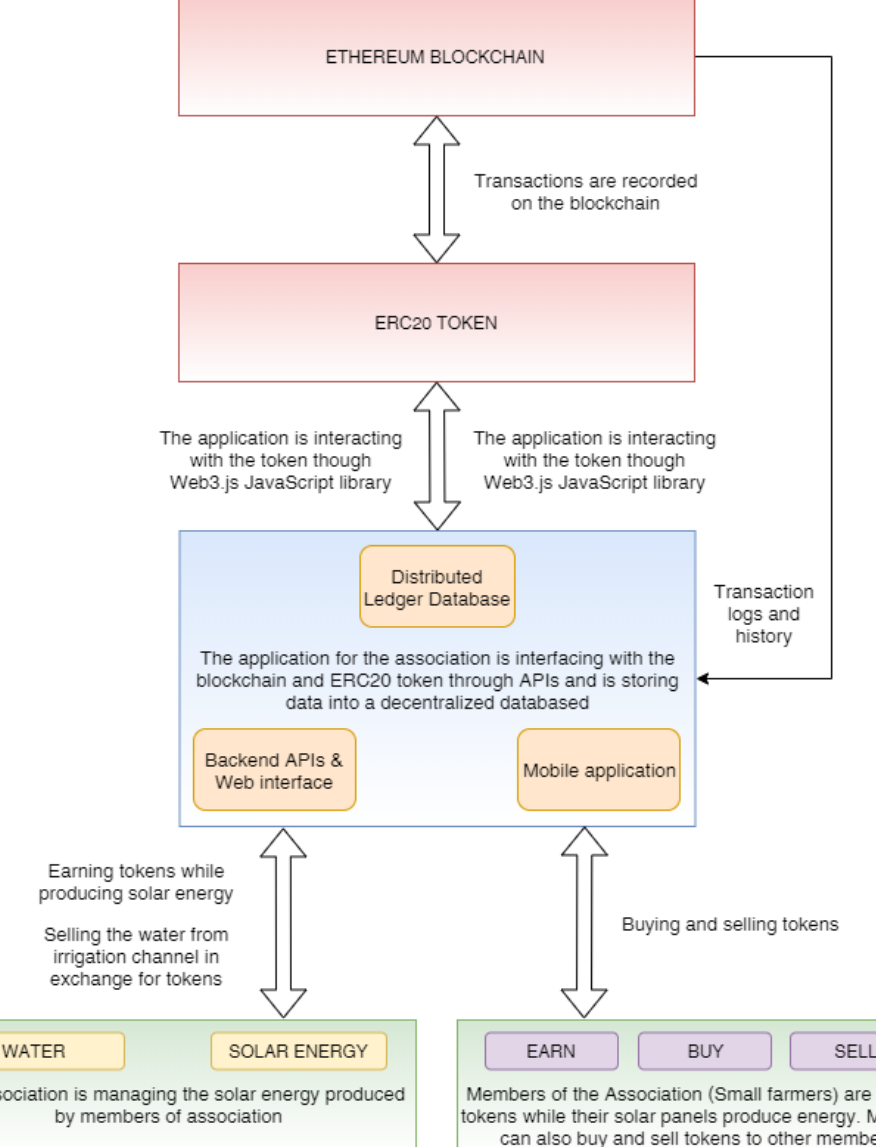
Figure 5. Blockchain-based smart contract system.